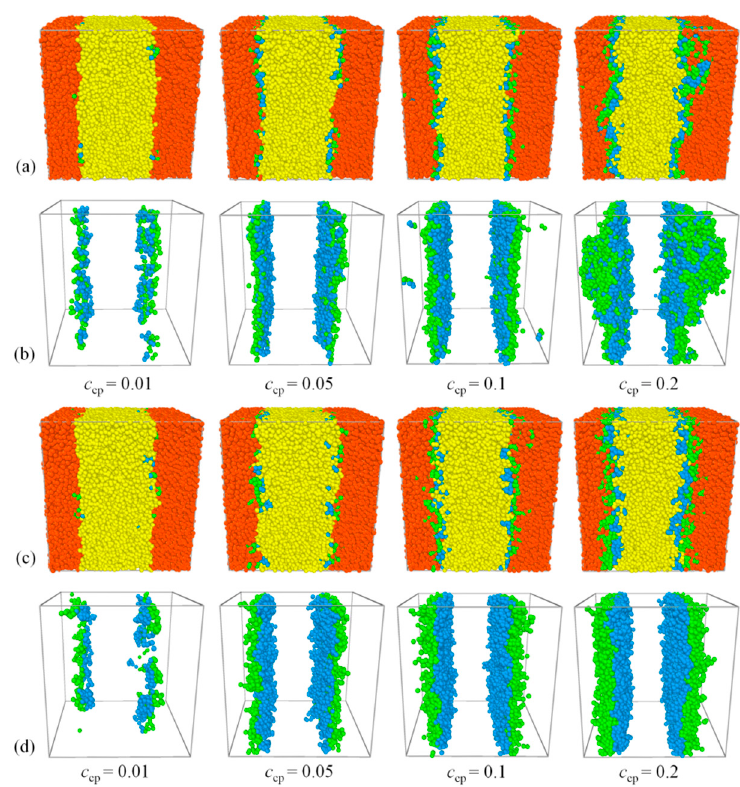
Figure 7. Morphology snapshots for ternary mixtures at different triblock copolymer concentrations. Compositions are ( a ) A 8 / A 2 B 4 A 2 / B 8 ; ( b ) A 2 B 4 A 2 ; ( c ) A 8 / A 7 B 14 A 7 / B 8 ; ( d ) A 7 B 14 A 7 . Red and yellow spheres represent bead A and bead B of homopolymers, and green and blue spheres represent beads A and B of copolymers.